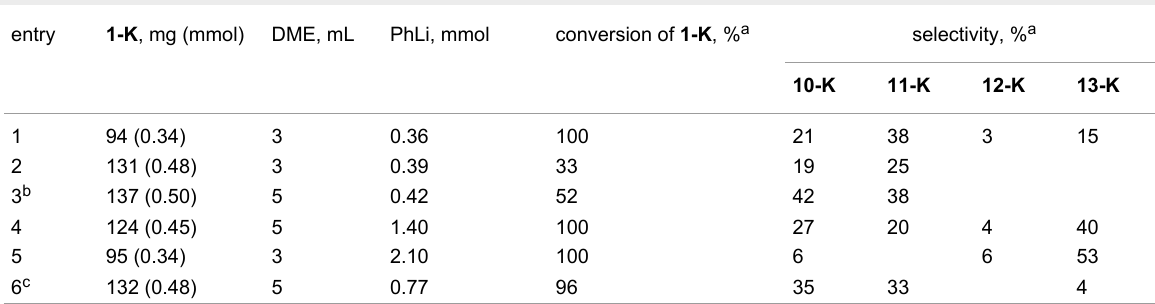
Table 3: Reaction of K[C 6 F 5 BF 3 ] ( 1-K ) with phenyllithium (22 °C, 2